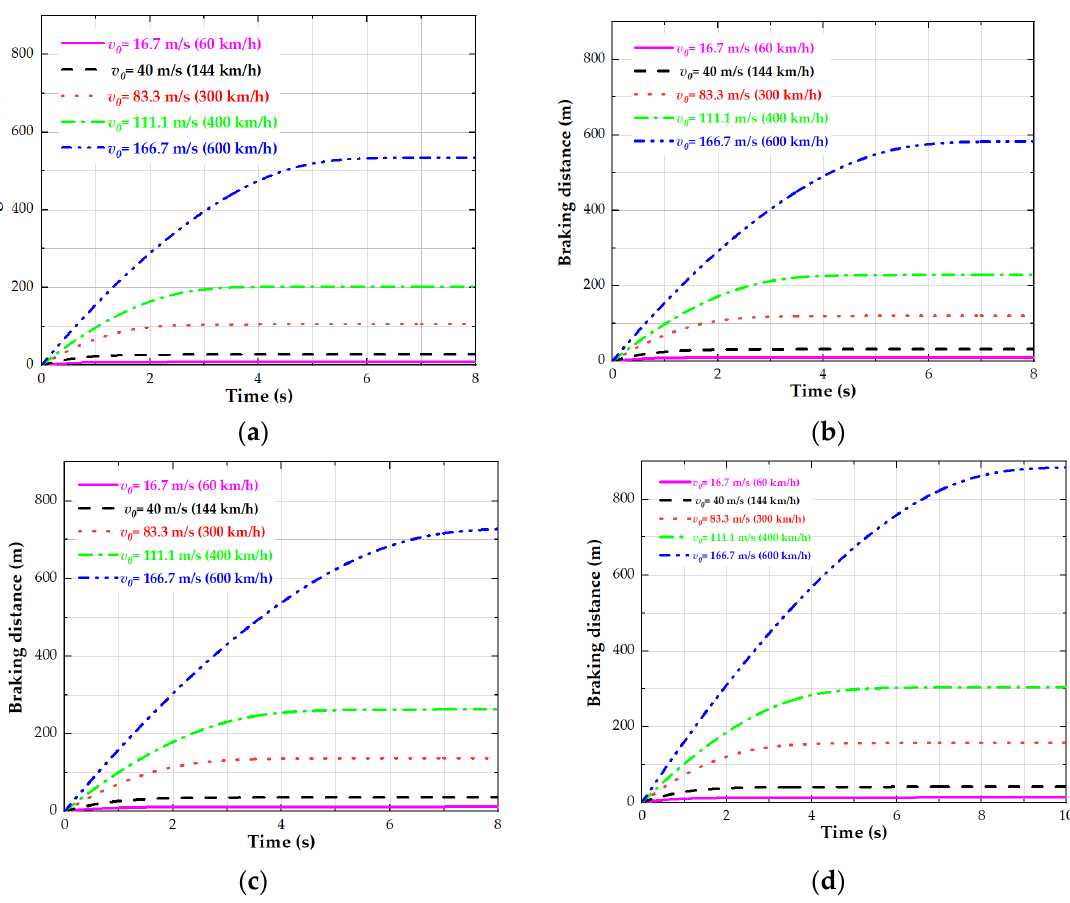
Figure 10. The change process in the braking distance at initial speeds of V 0 = 60 km/h, 144 km/h, 300 km/h, 400 km/h and 600 km/h under different air gaps: ( a ) under 5 mm air gap, ( b ) under 10 mm air gap, ( c ) under 15 mm air gap, ( d ) under 20 mm air gap. Table 4. Braking effects under different air